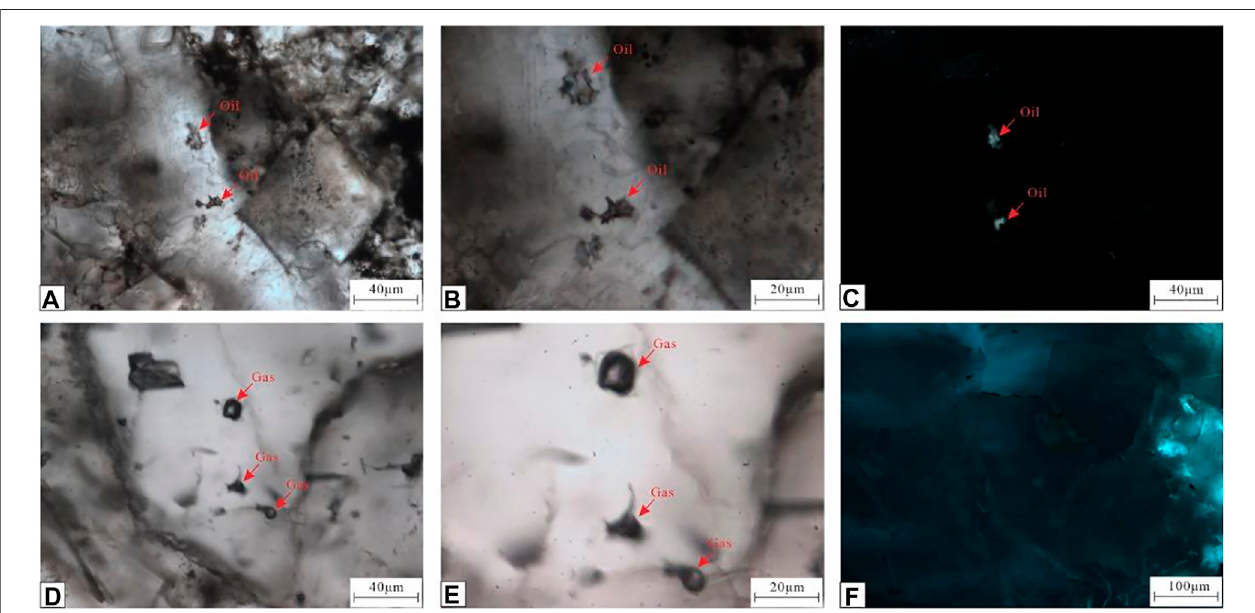
FIGURE 12 | Characteristics of fl uid inclusions in Ordovician carbonate reservoirs in Repu block. (A – C) are liquid inclusions, (D – F) are gas phase inclusions (A – C) are liquid inclusions, DEF are gas phase inclusions.